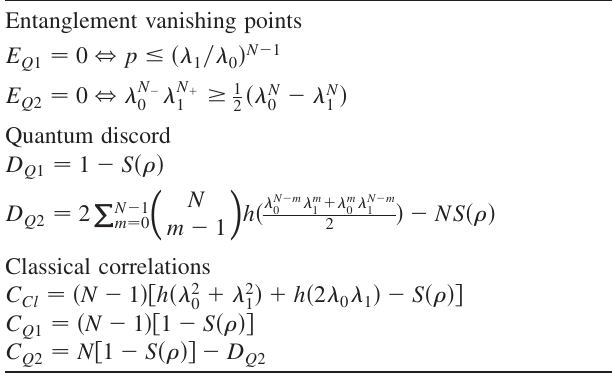
TABLE II. Entanglement vanishing points as functions of p for the states of strategies Q1 and Q2 are given. The expressions for discord (and therefore classical correlations) are conjectured and supported by numerical studies (see Fig. 3). These quantum and classical correlations are plotted as functions of p in Figs. 4 (a) and 4(b). Below, N (cid:2) ¼ ð N (cid:2) 1 Þ = 2 if N is odd and N (cid:2) ¼ N= 2 if N is even. S ð (cid:1) Þ ¼ (cid:1) tr ½ (cid:1) log ð (cid:1) Þ(cid:7) is the von Neumann entropy and h ð x Þ ¼ (cid:1) x log ð x Þ